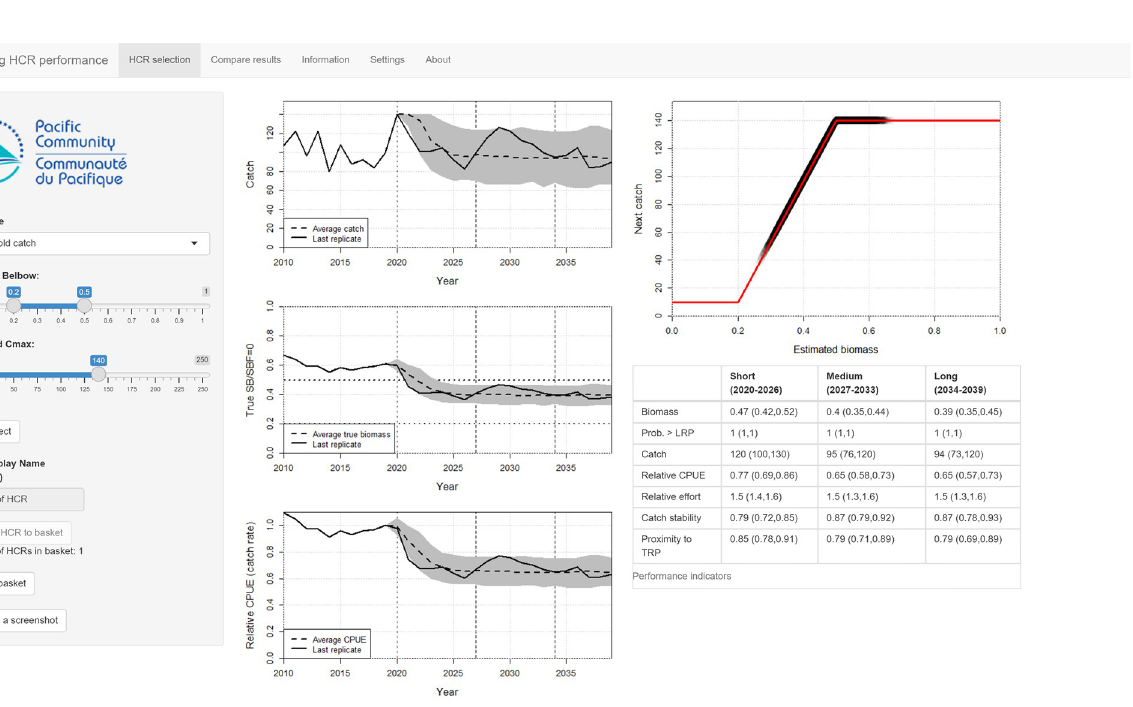
PLOS ONE | https://doi.org/10.1371/journal.pone.0269543 June 8,